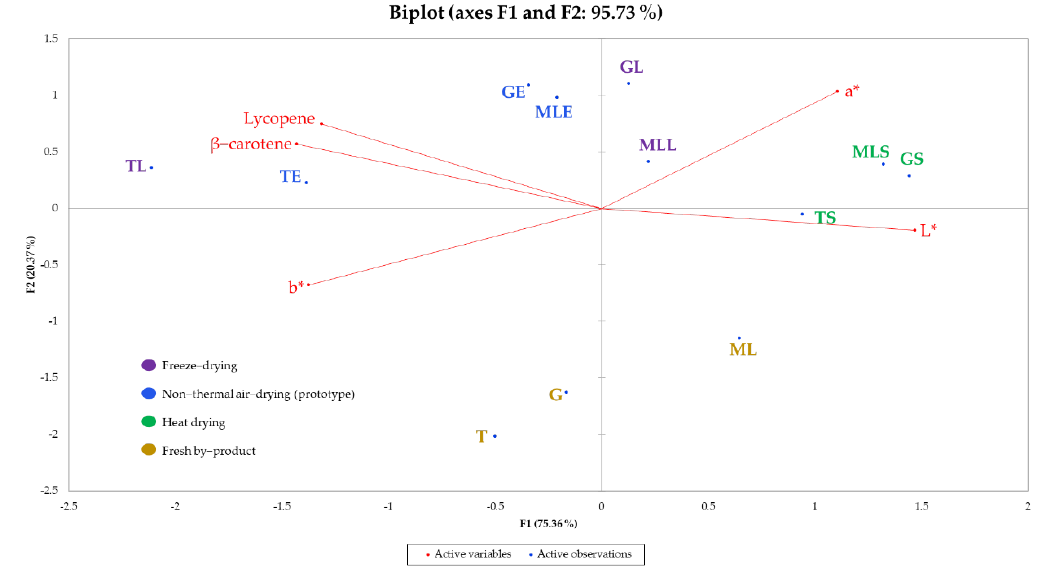
Figure 1. PCA biplot built with the results of the color analysis and the lycopene and β -carotene content for all the samples under consideration.